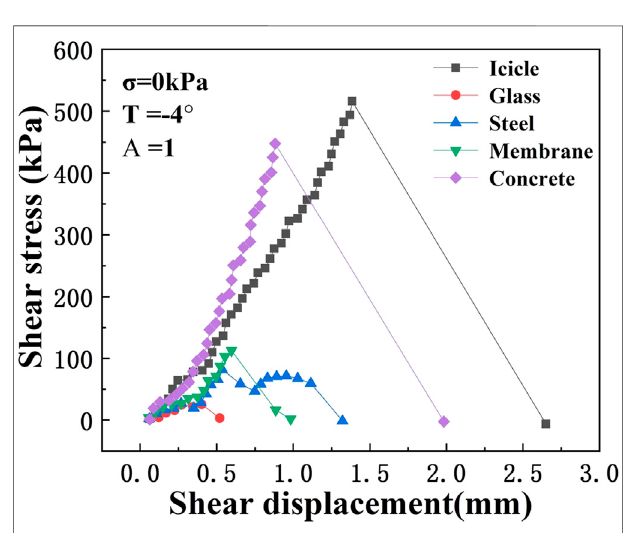
FIGURE 7 | An example of the shear stress – shear displacement curve when normal stress σ =0 kPa, temperature T = − 4 ° C, and contact area ratio A